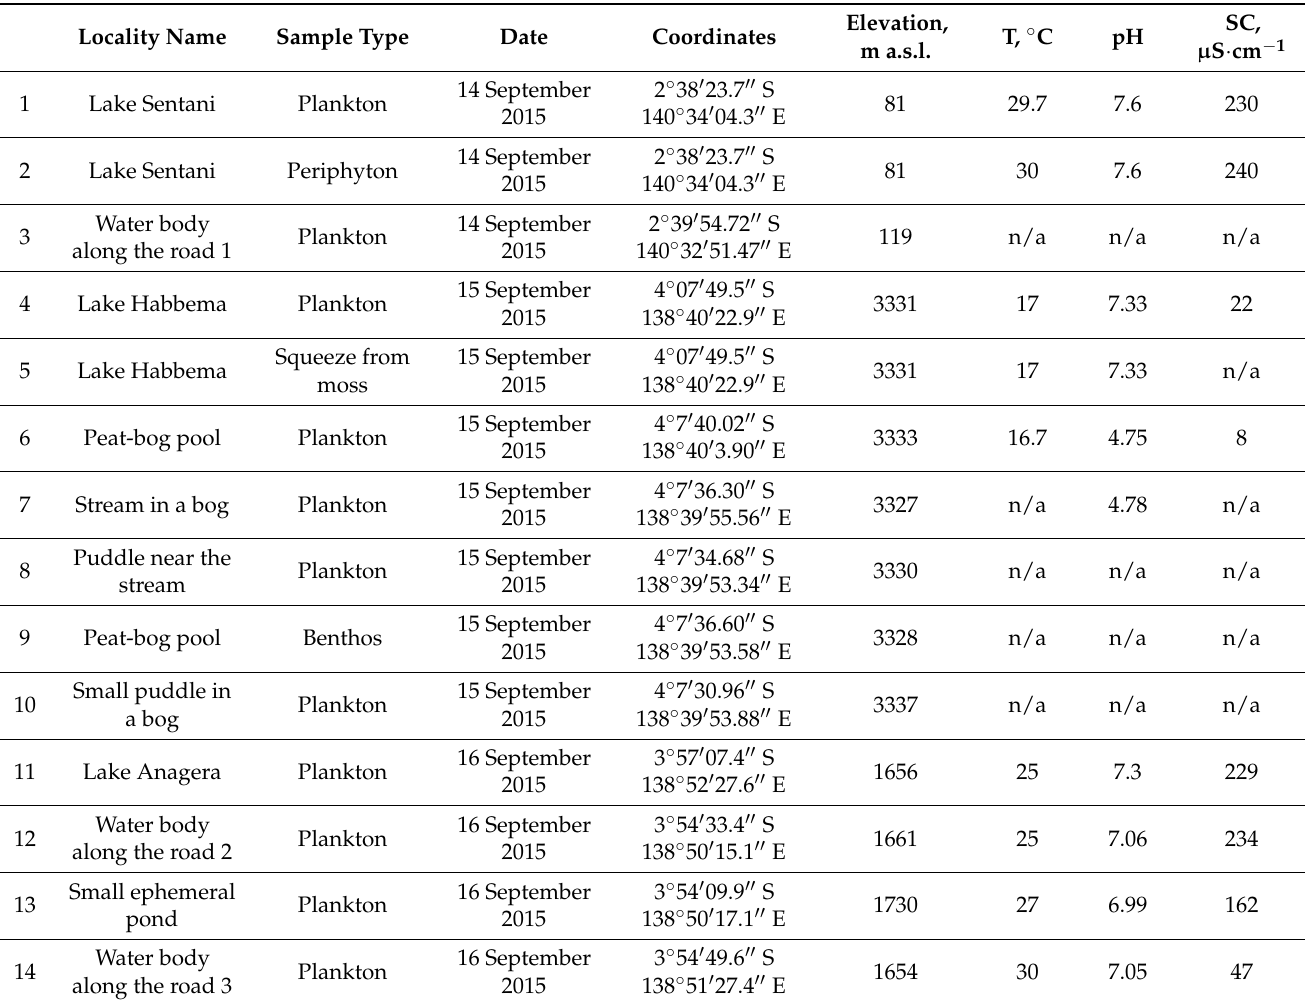
Table 1. List of the sampling sites with environmental variables (T—temperature, SC—specific conductance and n/a—no parameters were